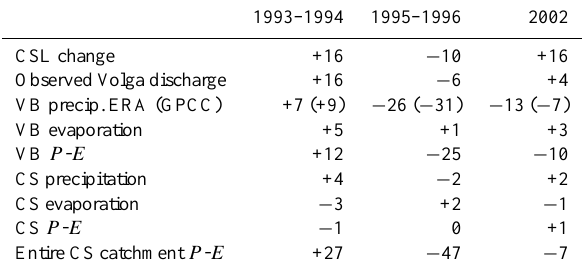
Table 3. Water budget component anomalies for the Caspian Sea catchment area for three periods. Units: change of the Caspian Sea level per years in cm. For abbreviations see Table